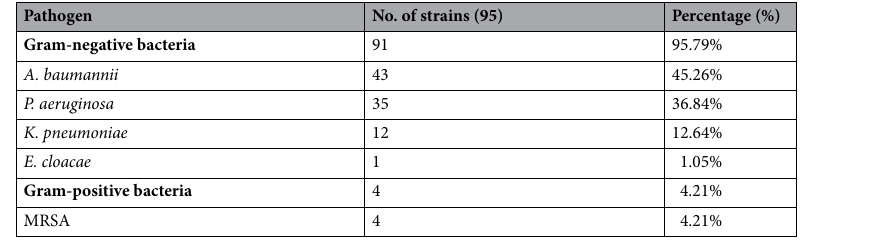
Table 2. Compositions of multidrug-resistant pneumonitis pathogens in the rehabilitation ward. A. baumannii : Acinetobacter baumannii; P. aeruginosa : Pseudomonas aeruginosa ; K. pneumoniae: Klebsiella pneumoniae ; E. cloacae: Enterobacter Cloacae ; MRSA: Methicillin-resistant staphylococcus